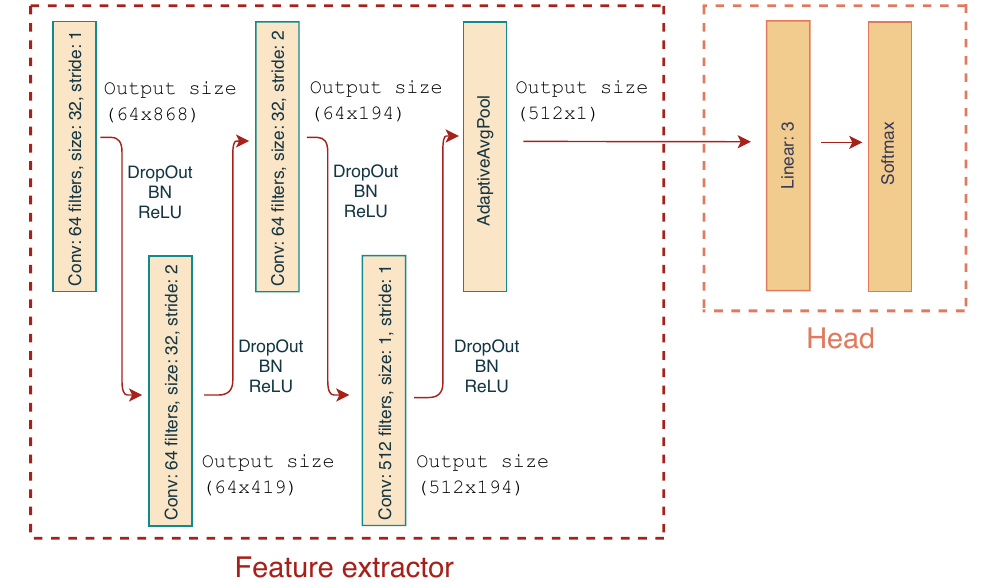
Figure 5. 1D CNN Architecture consisting of a feature extractor and head segments. The network was trained with AdamW optimiser [32] at a learning rate of 1 × 10 − 4 utilising a one-cycle training policy [33] and cosine learning rate annealing. The batch size was set to 256. The network was trained to a maximum of 50 epochs with early ending when validation loss reached a plateau [34] at a patience of 15 epochs and delta change 0.01. Furthermore for all results, a weight decay at a λ of 0.01 was used. The optimum model is selected from the training cycle after the completion of the